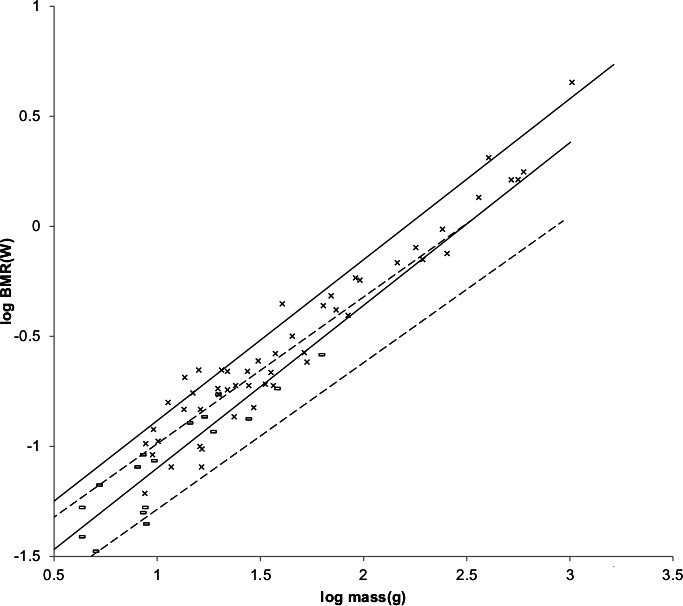
Log BMR as a function of log body mass for heavy and light bats.The solid and dashed lines are the MMLE sturdiness factor boundaries. The upper boundaries were generated with a sturdiness factor s = (3)0.5. The lower boundaries were generated with s = (3)−0.5. The steeper sloping solid boundary lines are for heavy bat Strouhal dynamic similarity. The shallower sloping dashed boundary lines are for light bat geometric similarity. \documentclass[12pt]{minimal}
\usepackage{amsmath}
\usepackage{wasysym}
\usepackage{amsfonts}
\usepackage{amssymb}
\usepackage{amsbsy}
\usepackage{upgreek}
\usepackage{mathrsfs}
\setlength{\oddsidemargin}{-69pt}
\begin{document}
}{}${R}_{M}^{2}=0.9828$\end{document}RM2=0.9828 for heavy bats with respect to the Strouhal boundaries. \documentclass[12pt]{minimal}
\usepackage{amsmath}
\usepackage{wasysym}
\usepackage{amsfonts}
\usepackage{amssymb}
\usepackage{amsbsy}
\usepackage{upgreek}
\usepackage{mathrsfs}
\setlength{\oddsidemargin}{-69pt}
\begin{document}
}{}${R}_{M}^{2}=0.9984$\end{document}RM2=0.9984 for light bats with respect to the geometric boundaries. Heavy bat species-averaged data are marked with Xes. Light bats species-averaged data are marked with open rectangles. Data was available for only four of the eight families comprising the light bats.